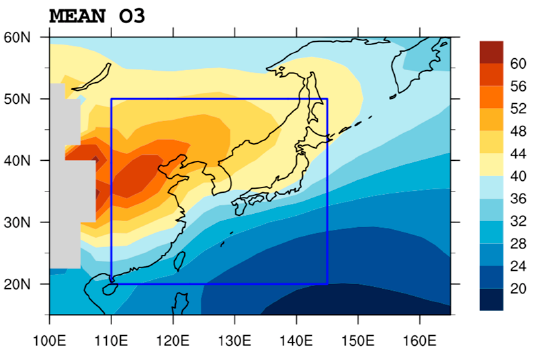
Figure 1. Multi-model mean (MMM) surface (850 hPa) ozone concentration (ppbv) during summer from 1979 to 2010. Rectangular box denotes the East Asian region (20°–50° N and 110°–145° E).